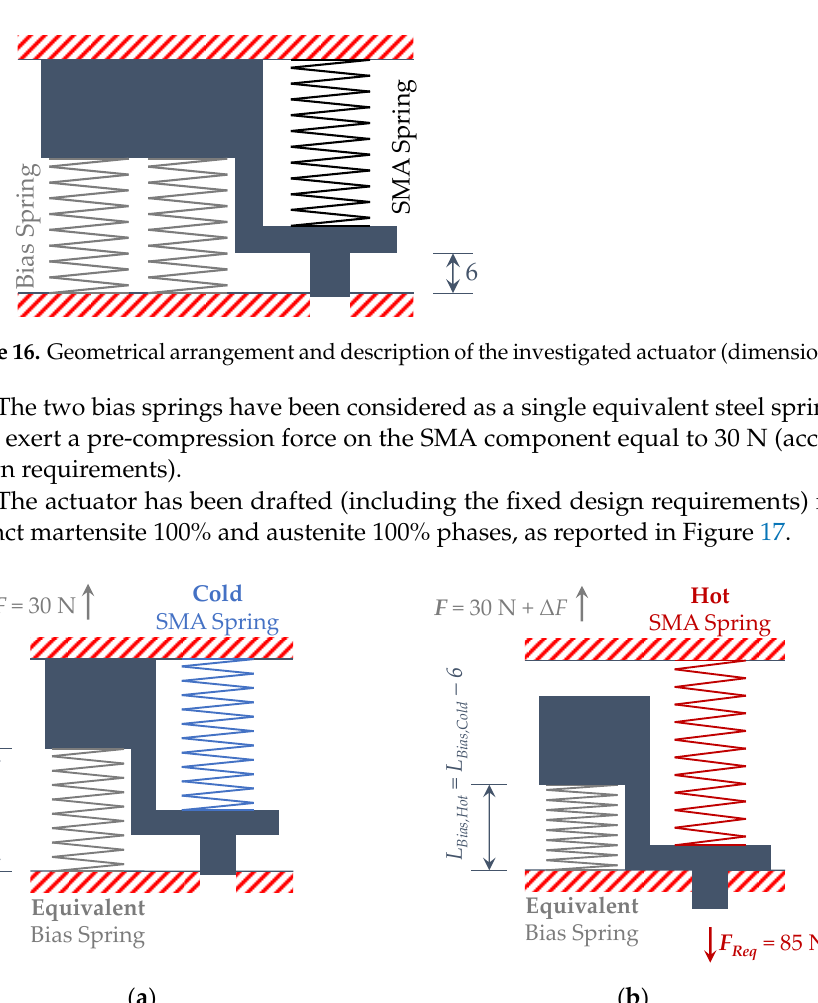
( b ) Figure 14. SMA (austenite) compression tests: ( a ) force–displacement; ( b ) temperature variation during time. Figure 15. Material properties of austenite. Table 4. Specific material values for austenite. Property